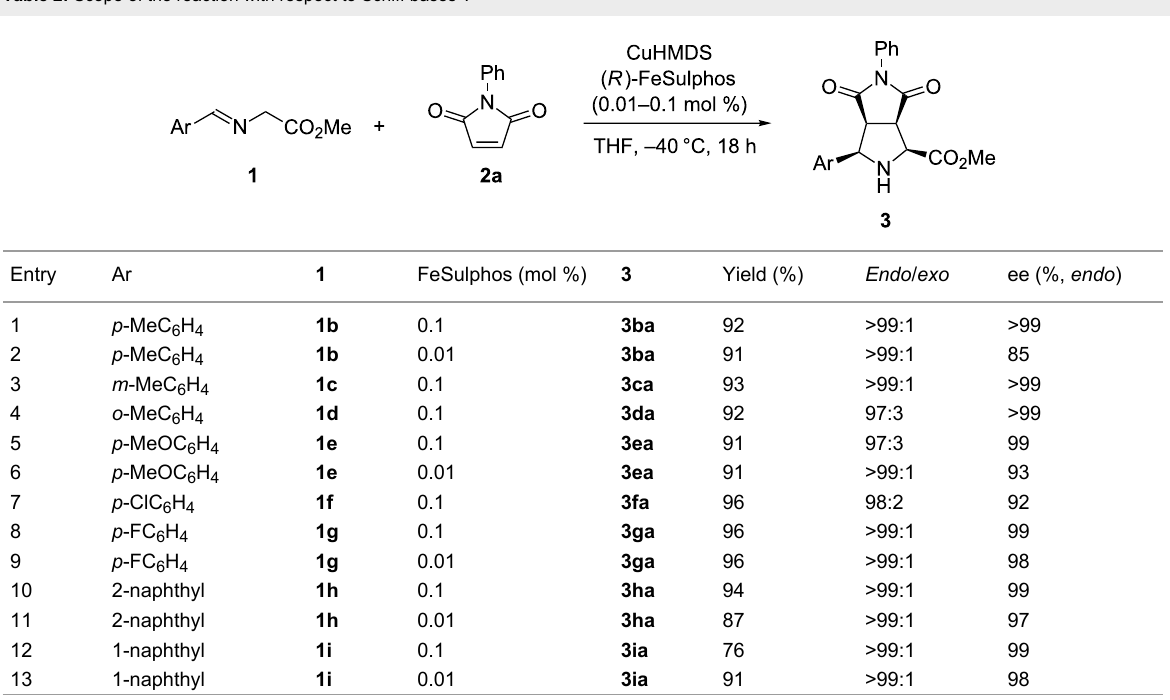
Table 2: Scope of the reaction with respect to Schiff bases a